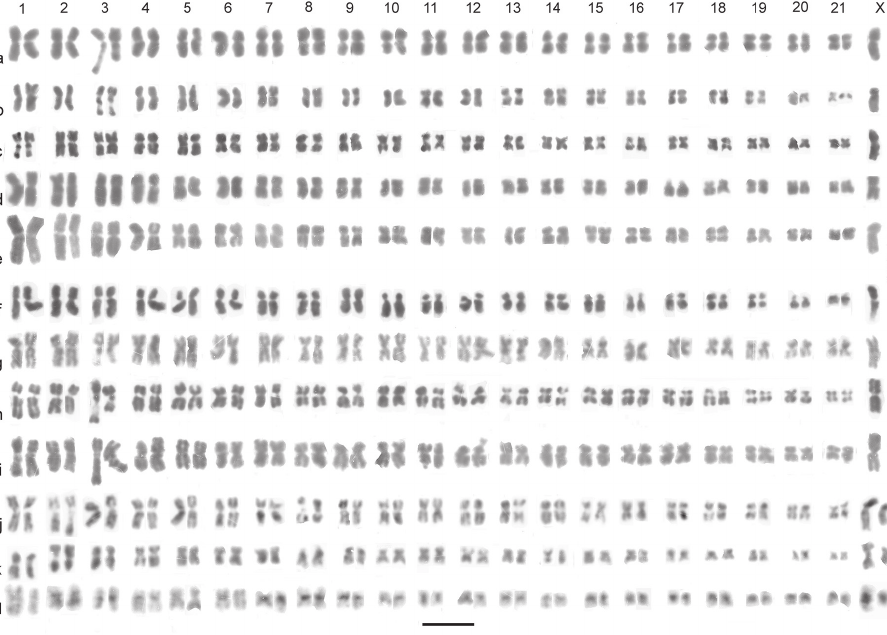
Figure 4. Agabus ( Gaurodytes ) part 2, mitotic chromosomes arranged as karyotypes. a , b A. biguttatus , ♂ , mid-gut, plain: a El Noqra b Giara di Gesturi; c A. binotatus , ♂ , mid-gut, plain d A. affinis , ♂ , mid-gut, plain e A. unguicularis , ♂ , mid-gut, plain f A . ramblae , ♂ , Murcia, testis, plain g A. conspersus , ♂ , mid- gut, plain h , i A. nebulosus , ♂ , mid-gut, plain h Cuckmere i Tenerife j–l A. adpressus , ♂ , mid-gut j plain k, l the same nucleus k plain l C-banded. Bar = 5